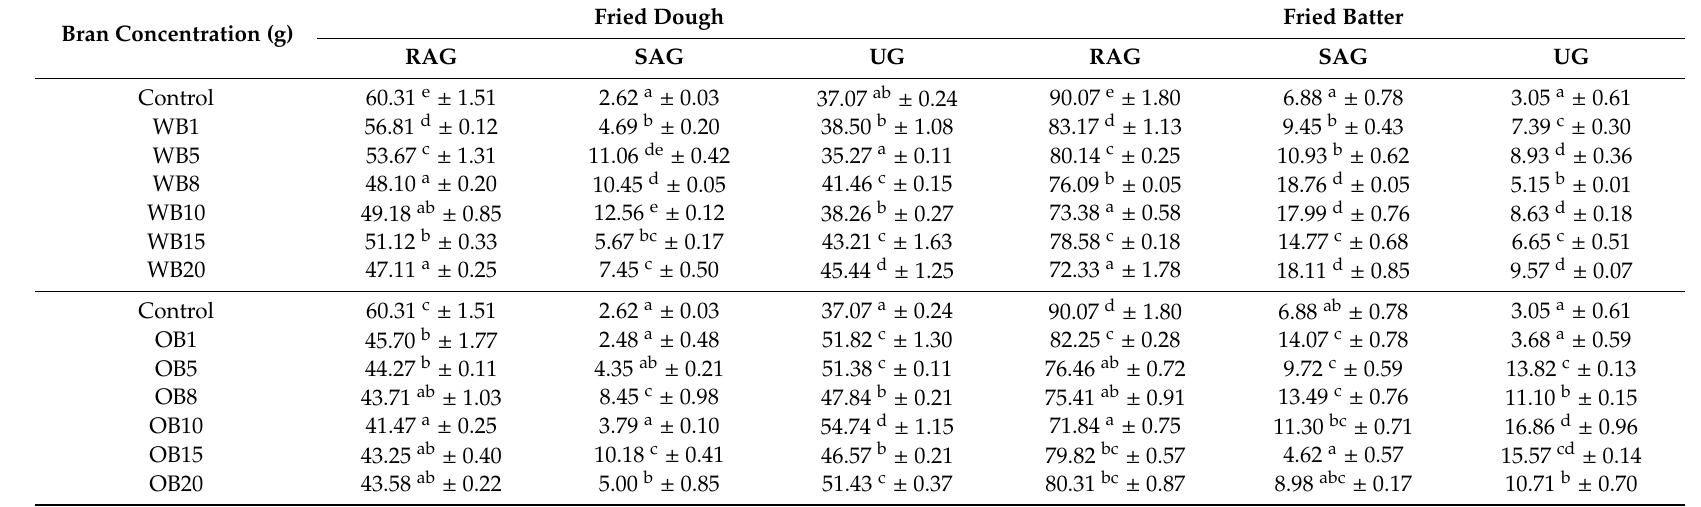
Table 1. Glucose content (g / 100 g) of fried products enriched with wheat and oat